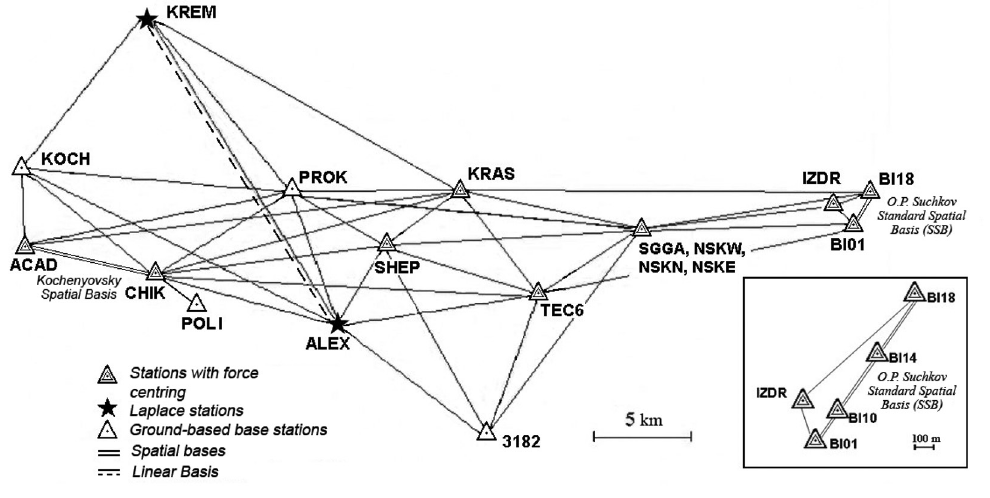
Figure 1. GSPG network and O. P. Suchkov Standard Spatial Basis (SSB) of the